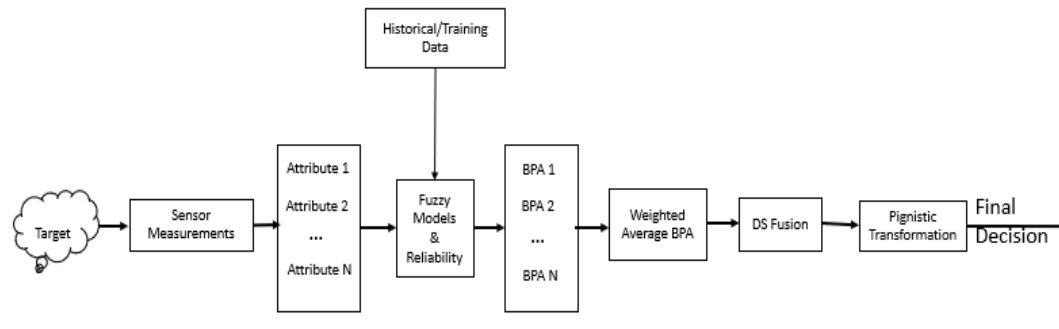
Figure 4. The flowchart of the proposed multisensor data fusion for target